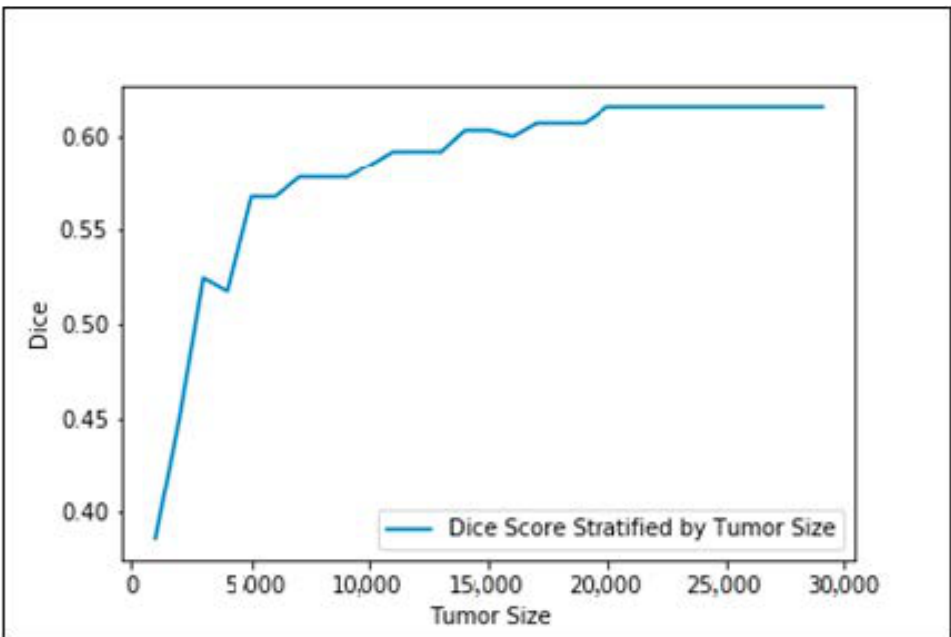
Figure 5. Qualitative comparison of different models for small tumor segmentation. ( a ) Input fluid attenuated inversion recovery (FLAIR) image. ( b ) Input T1 image and ( c ) ground truth images. ( d ) Results of our method. ( e ) Results of ReversibleUnet [48]. ( f ) Results of No New-Net [49]. ( g ) Results of DMFNet [43].